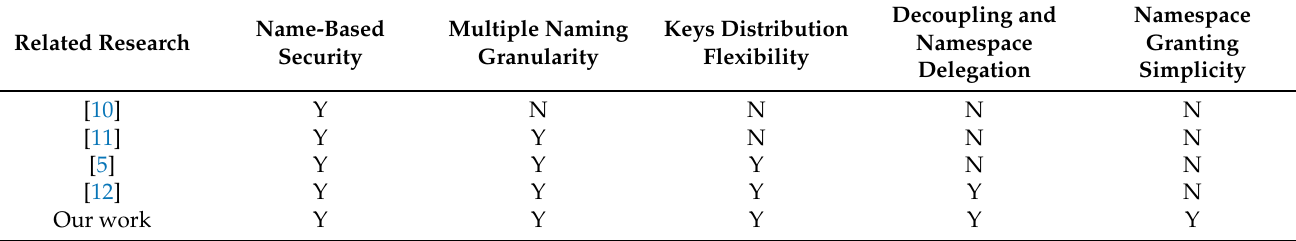
Table 1. Comparison of NACDA With Other Name-based Access